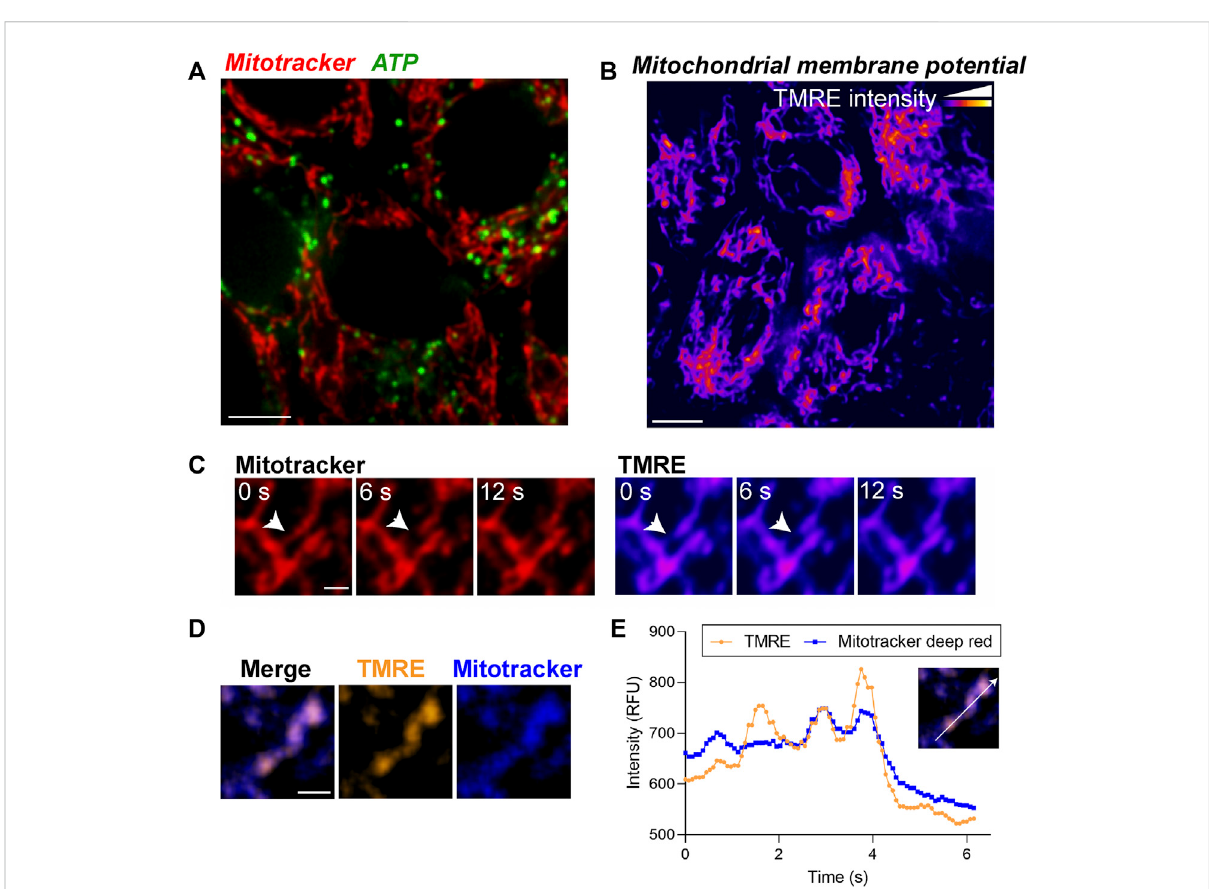
FIGURE 3 Live imaging of ATP and mitochondrial membrane potential demonstrates morphological and functional heterogeneity of mitochondria in the RPE. (A) Stills from live imaging of mitochondria (Mitotracker, red) and BioTracker-ATP (green) in primary RPE monolayers. (B) Mitochondrial membranepotential (MMP) measuredby TMRE labeling in primary RPEmonolayers. Color scale: warmercolorsindicate higher TMRE intensities. (C) High magni fi cation images showing local heterogeneity of MMP within a single mitochondrion. Note that areas of low TMRE intensity predict putative fi ssion sites (arrow). Scale bar = 1 µM. Also see Supplementary Movies S3. (D) Overlay of TMRE (gold) and Mitotracker deep red (blue). Note that TMRE is more sensitive to local MMP heterogeneity within a single mitochondrion compared to Mitotracker deep red. Right panels show